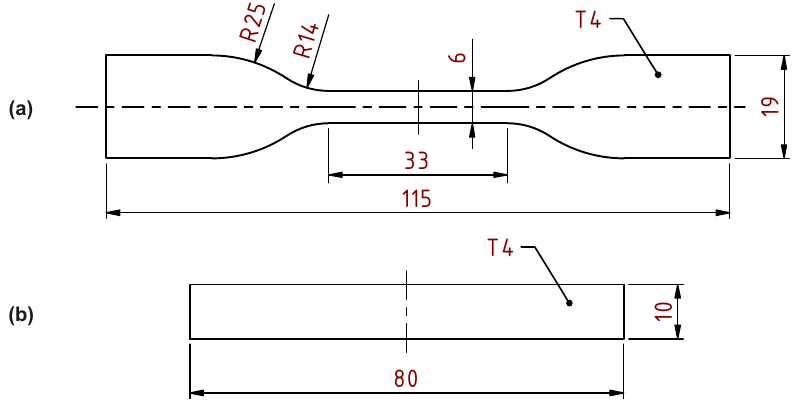
Figure 5. Specimens for ( a ) tensile; and ( b ) bending and impact tests.